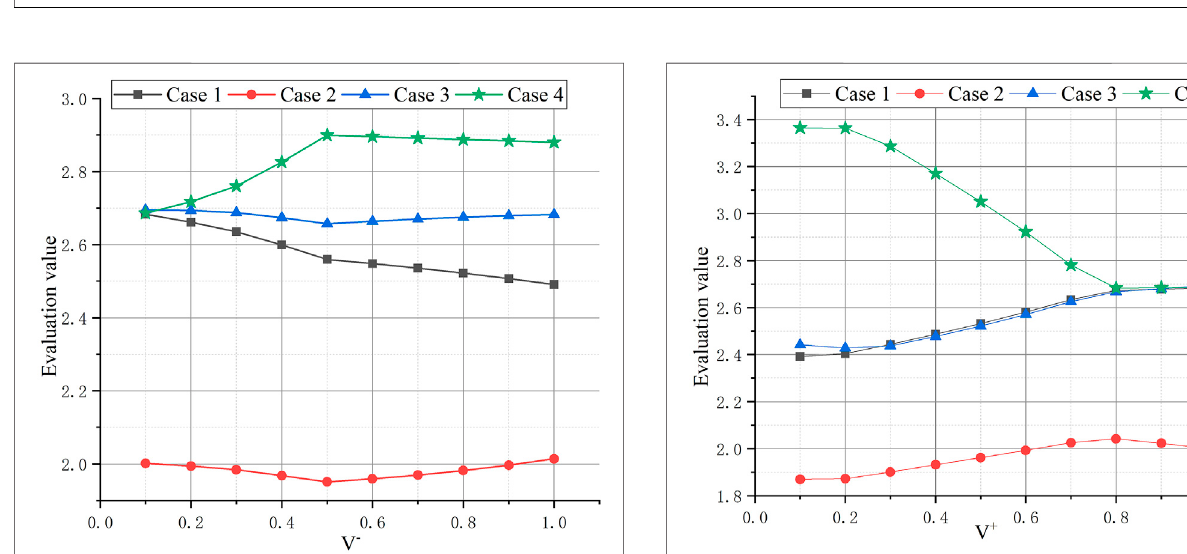
FIGURE 5 | Dynamic evaluation surfaces of each scheme under different V + , V − .